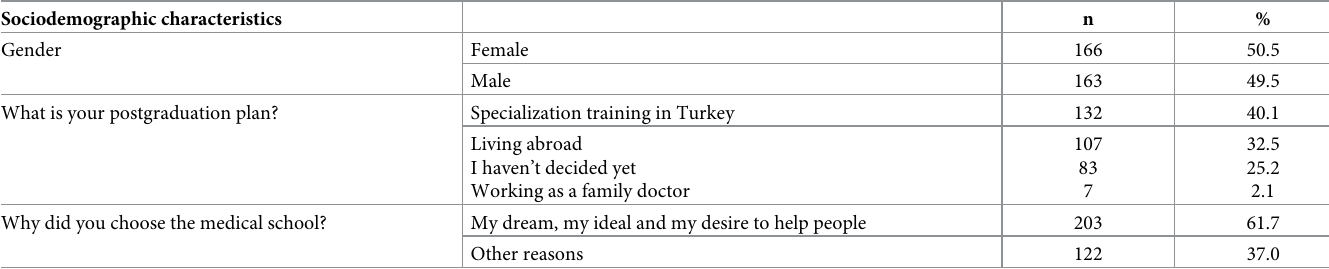
Table 2. Sociodemographic characteristics of participants. Sociodemographic